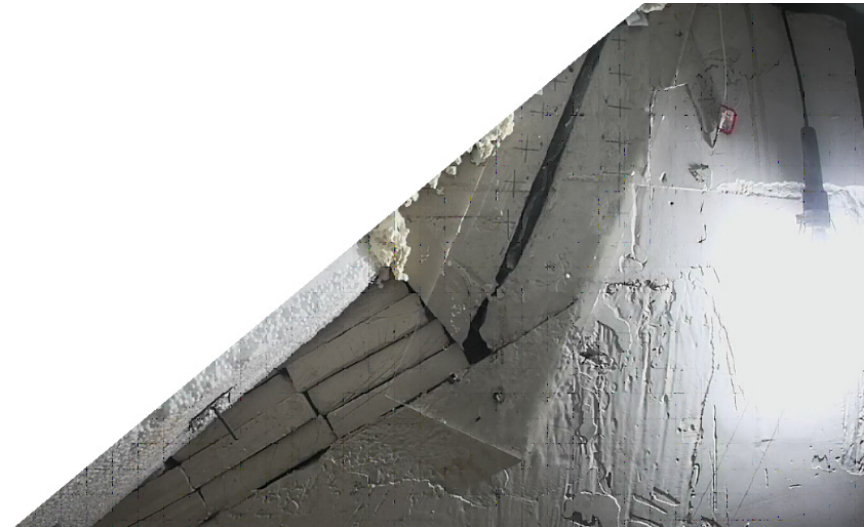
Figure 9. The shape of the sliding slope caused by the freeze–thaw effect.